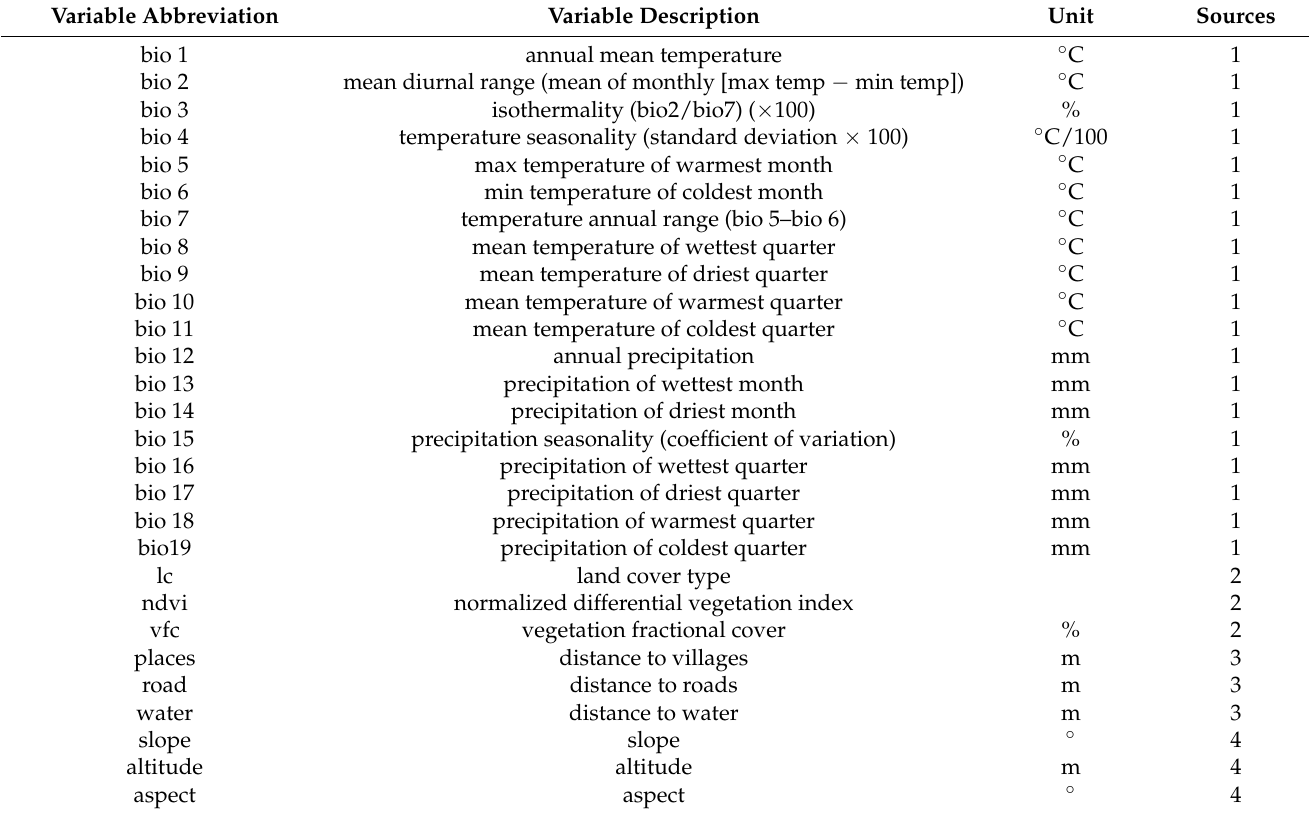
Table 1. The 28 environmental factors used in the construction of the MAXENT model (including bioclimate, human disturbance, topography, vegetation, and soil